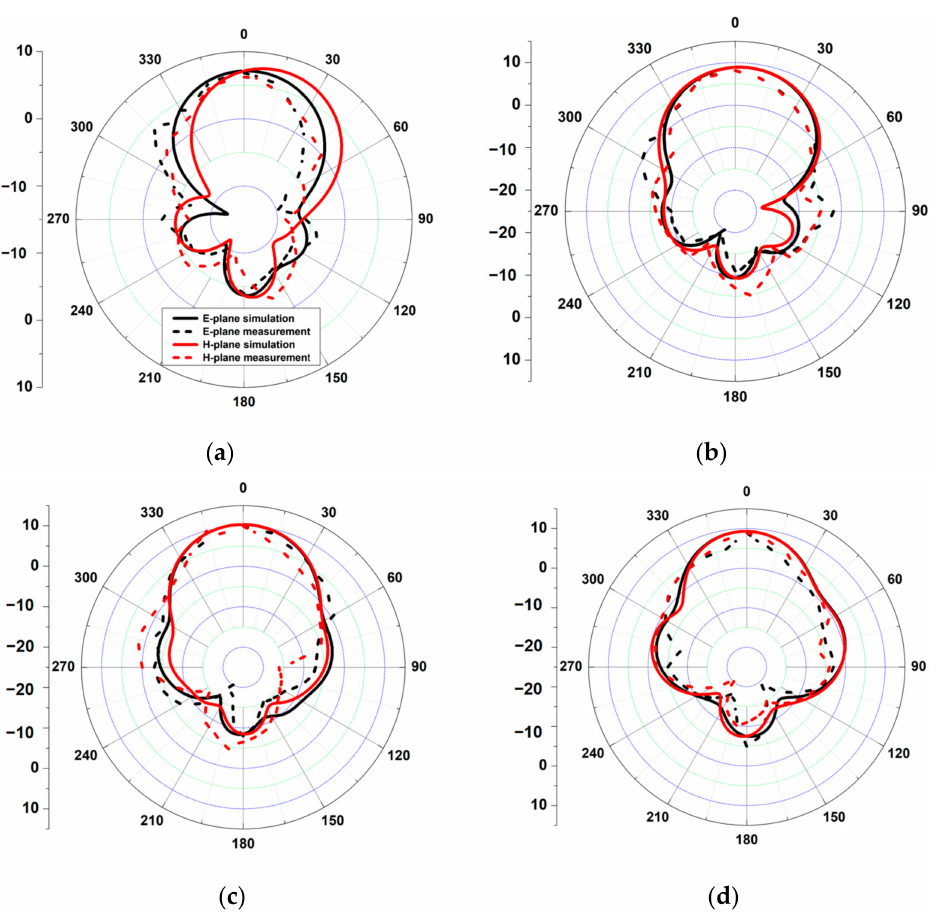
Figure 9. Measured and simulated radiation patterns of the proposed wideband and CP antenna at: ( a ) 1.8 GHz; ( b ) 2.1 GHz; ( c ) 2.45 GHz; ( d ) 2.6 GHz.